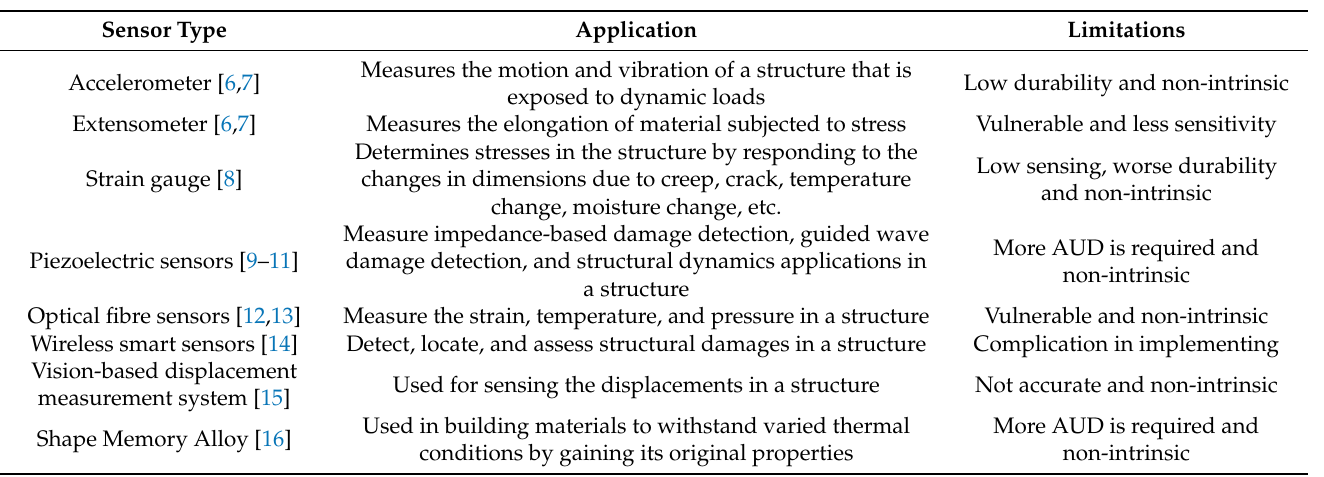
Table 1. Conventional Sensors Used in Building Aspects.